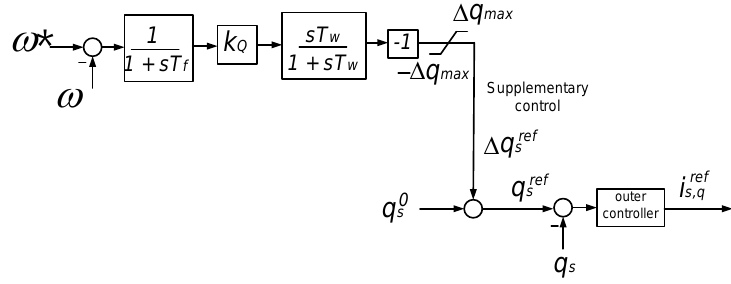
Figure 5. Control for the reactive-power injection of a